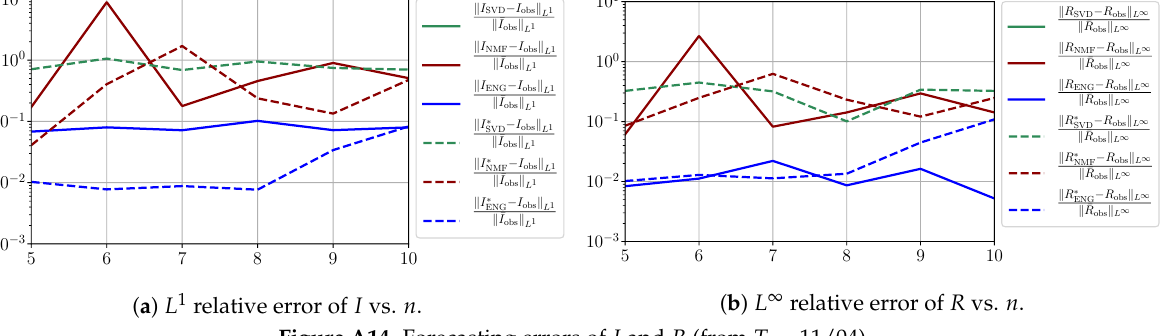
Figure A14. Forecasting errors of I and R (from T = 11/04).